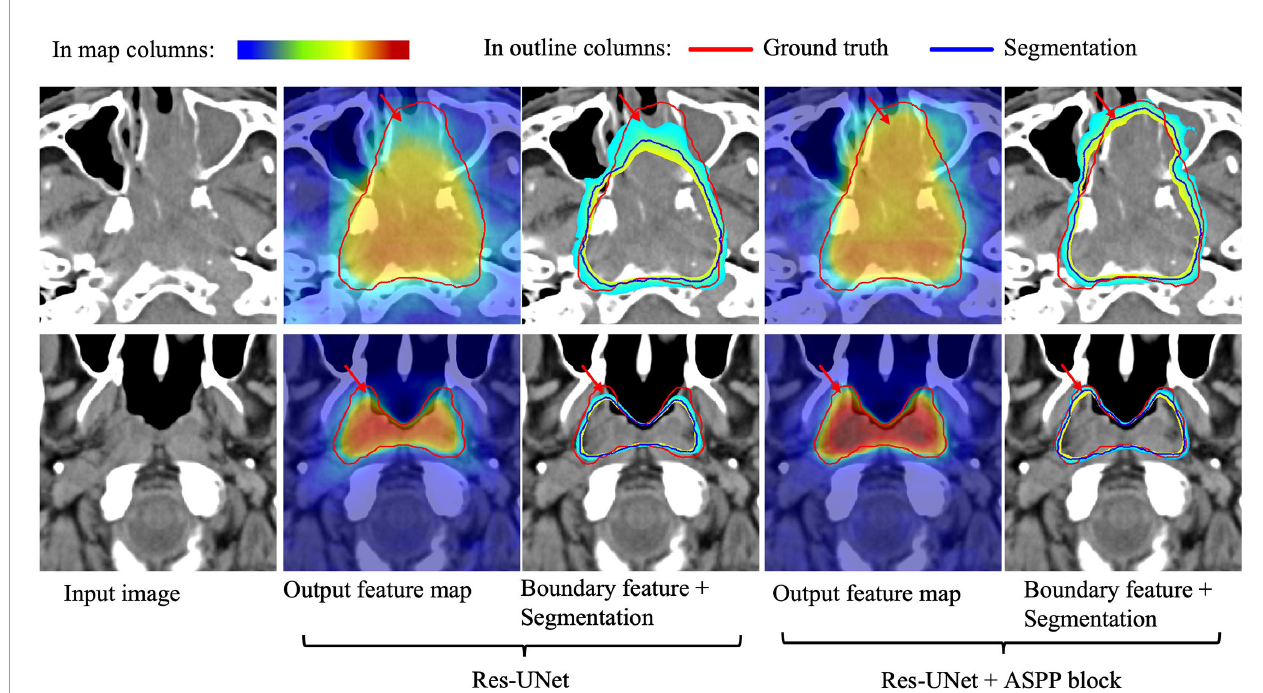
FIGURE 5 | Visual comparison of the boundary feature maps obtained by including the Res-UNet backbone and adding the ASPP block. Map columns: includes output feature maps and boundary feature maps, where warmer colors represent higher attention. Outline columns: red and blue denote the ground truth and automatic segmentation results, respectively. The red arrows denote boundary areas noticed by the ASPP block, which has better boundary segmentation performance. Note that the two rows are from different patients and shown in pCT.